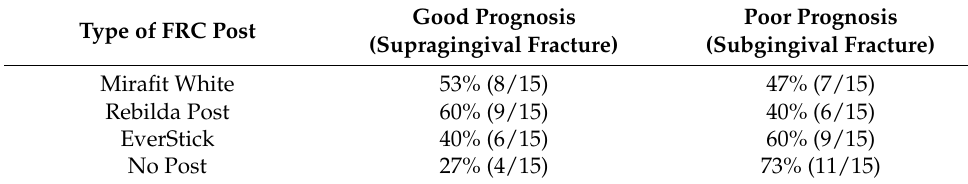
Table 2. Prognosis of tooth restoration possibilities after conducted strength test.